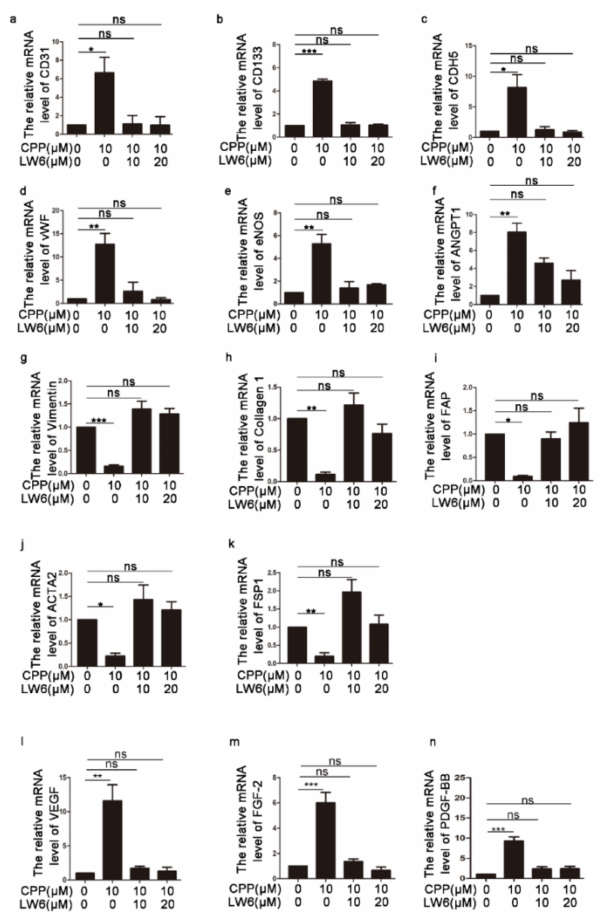
Figure 2. The effect of CPP on related genes after treatment with an inhibitor of HIF-1 α . ( a – n ) HDFs were pretreated with LW6, an inhibitor of HIF-1 α , for 12 h, and then treated with CPP (10 µ M) for 6 days (D6), and qPCR was conducted to detect the expression of EC genes (CD31, CD133, CDH5, vWF, eNOS and ANGPT1), fibroblastic genes (Vimentin, Collagen 1, FAP, ACTA2 and FSP1), and pro-angiogenic factors (FGF-2, VEGF, PDGF-BB). Data are presented as means ± SEM, * p < 0.05, ** p < 0.01, *** p < 0.001, n =